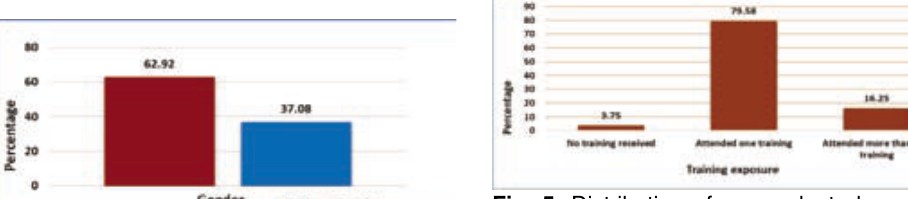
Fig. 5. Distribution of respondents based on Training exposure in biodiversity management All the respondents reported a working experience of 5 years in BMCs. Awards/recognitions received by members